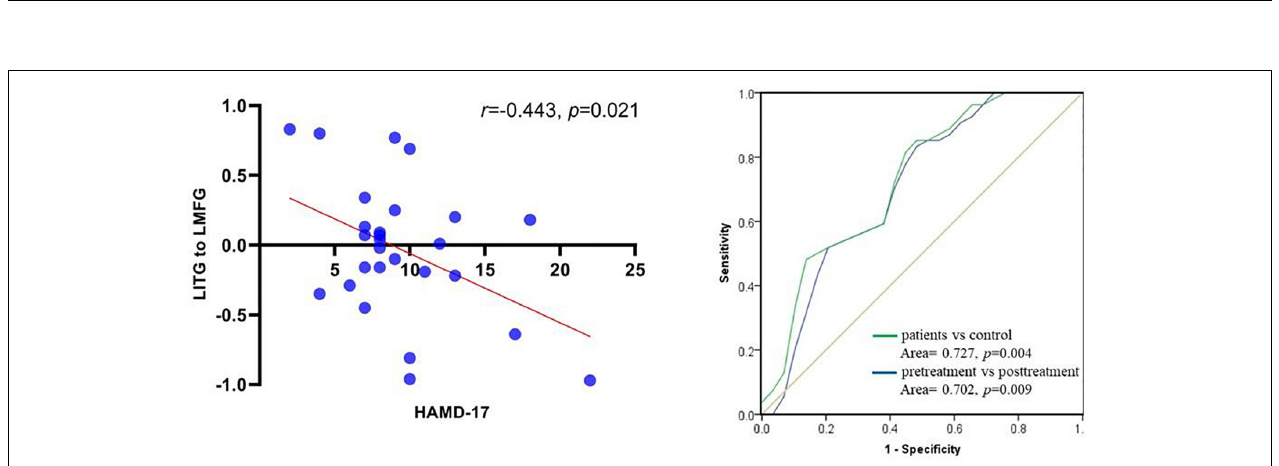
FIGURE 5 | Scatter plot between causal connectivity from left inferior temporal gyrus to left middle frontal gyrus and score of HAMD-17 in post- rTMS of patients with MDD (left); ROC curve for causal connectivity from inferior temporal gyrus to seed point with patients between patients (pretreatment and posttreatment) and control